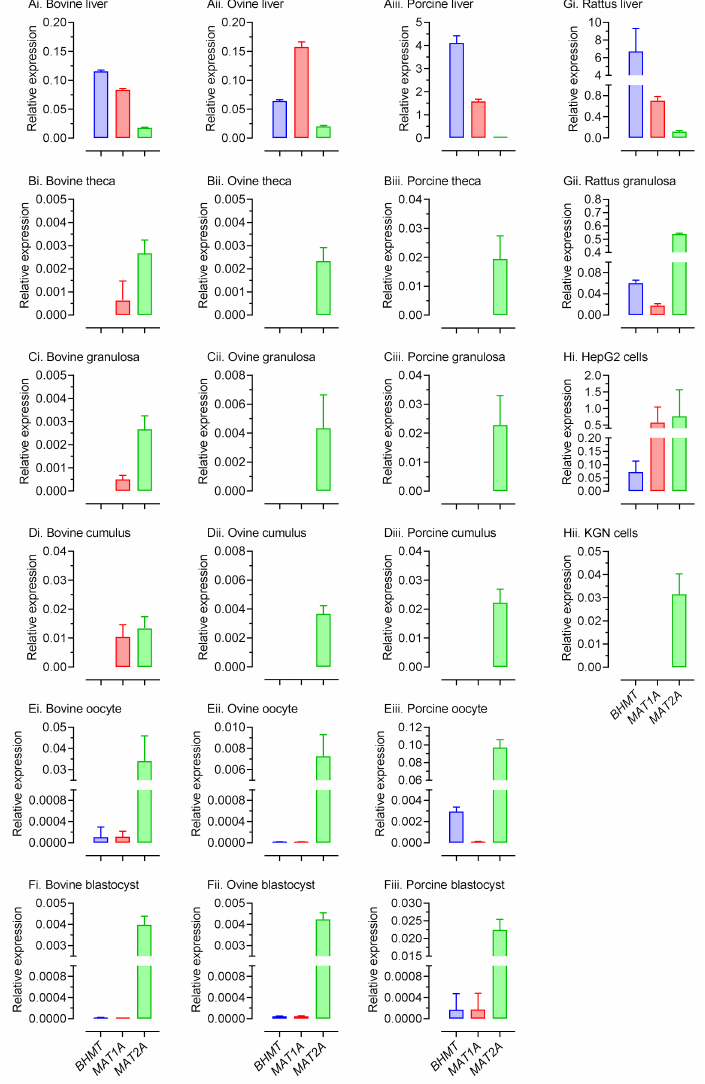
Figure 2. Relative (to ACTB ) expression of transcripts for three one-carbon (1C)-genes in the liver ( A i, ii, iii) and different somatic cell types of the ovarian follicle (theca, B i, ii, iii; granulosa C i, ii, iii; D i, ii, iii), the oocyte ( E i, ii, iii), and blastocyst ( F i, ii, iii) from three domestic animal species, together with transcript expression in rat granulosa cells ( G ii) and liver ( G i), and in two human cell lines (i.e., KGN (a granulosa-like tumor cell line; H ii) and human hepatocellular liver carcinoma cell line (HepG2) cells; H i) representing granulosa cells and liver,